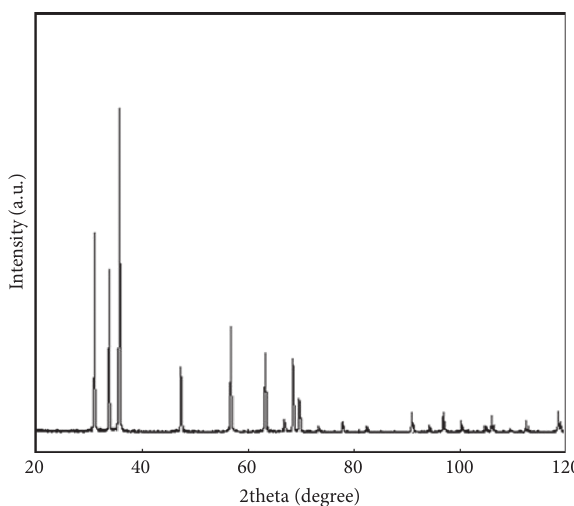
Figure 11: The X -ray diffraction (XRD) patterns of the ZnO